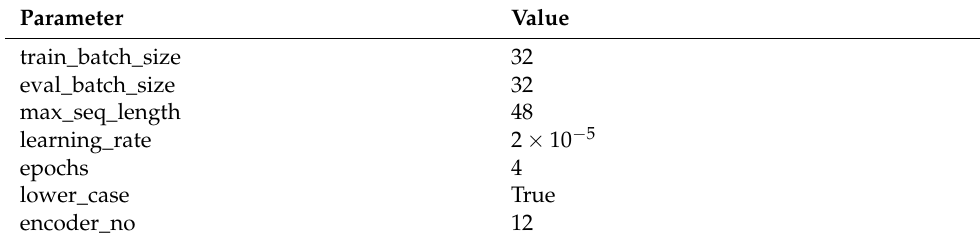
Table 2. Tested parameters.